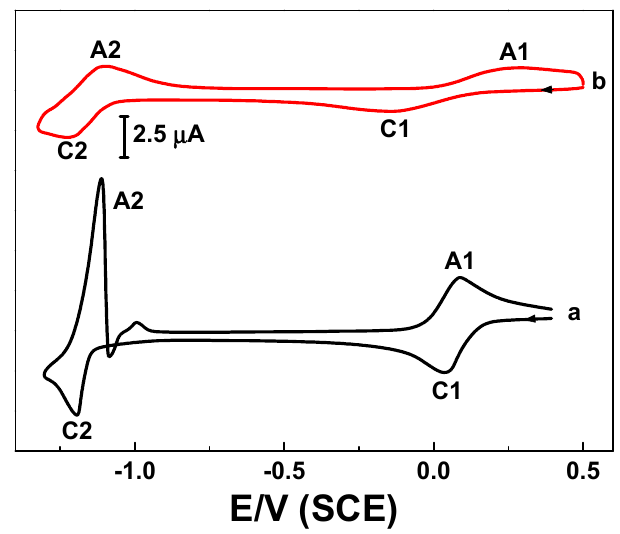
Figure 1. Voltammetry responses of 1 mM [Co(II)(bpy) 3 ] 2+ on a GCE (Glassy carbon electrode) in 0.1